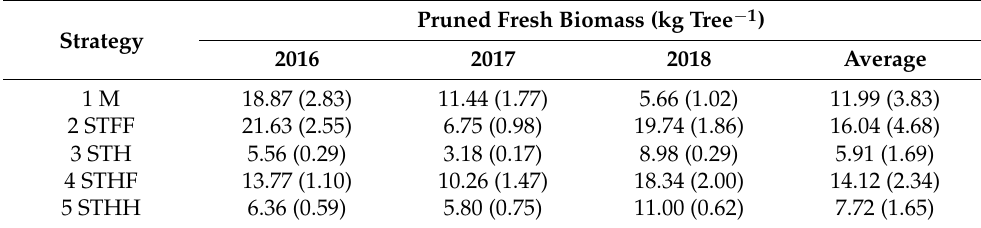
Table 6. Mean (standard error) values of pruned fresh biomass by pruning strategy.